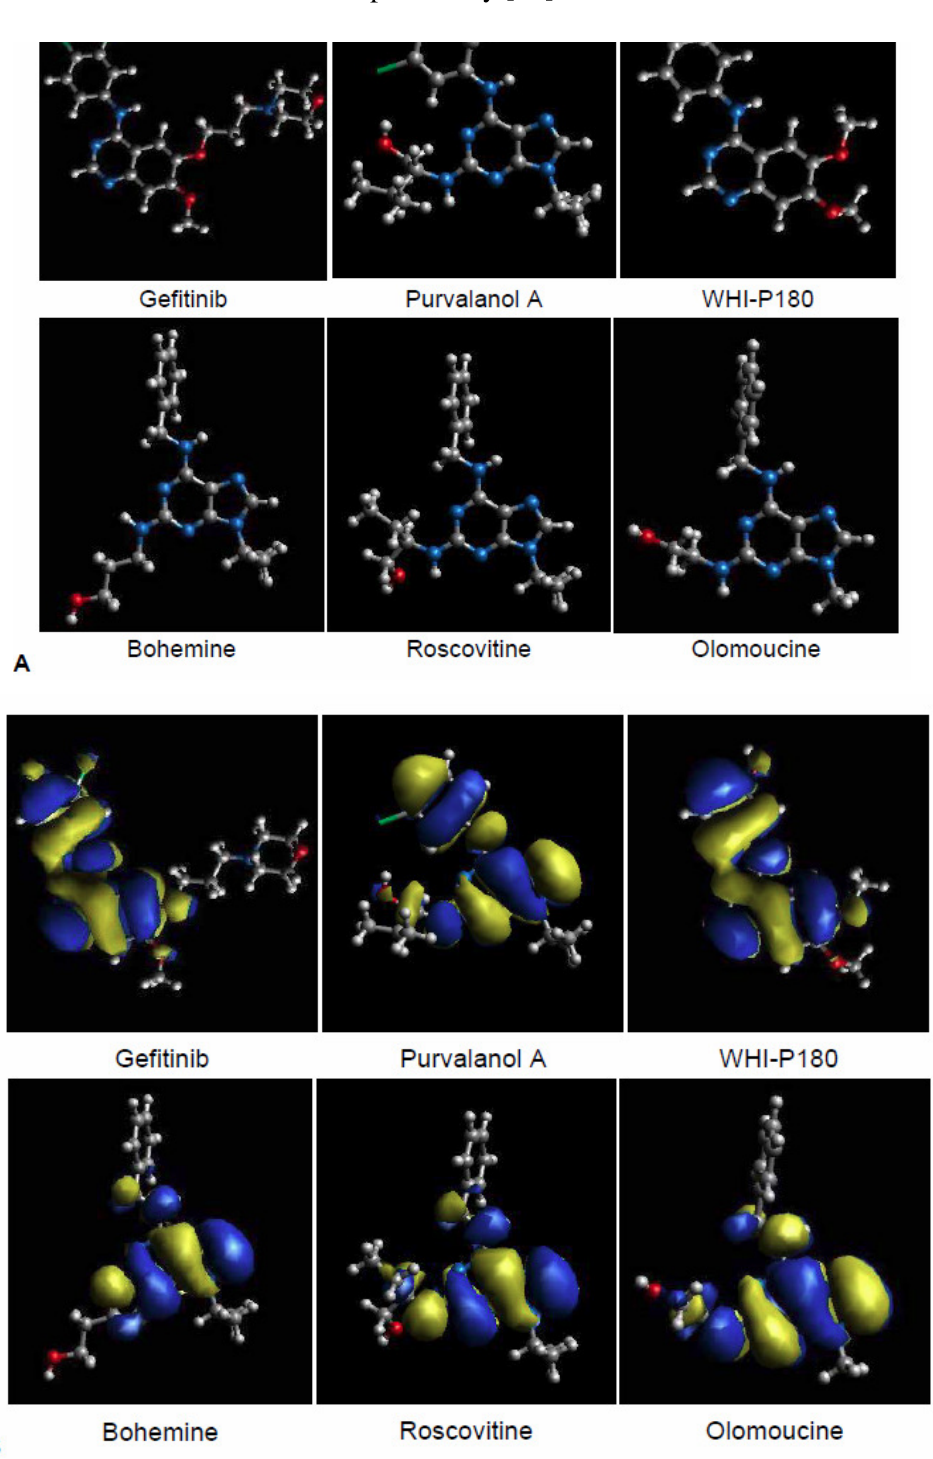
Figure 9. Putative three-dimensional (3D) structures of purvalanol A, WHI-P180, gefitinib, roscovitine, bohemine, roscovitine, and olomoucine. The 3D structures ( A ) and the highest occupied molecular orbits (HOMO) ( B ) of those CDK inhibitors were generated by ab initio MO calculation as described previously